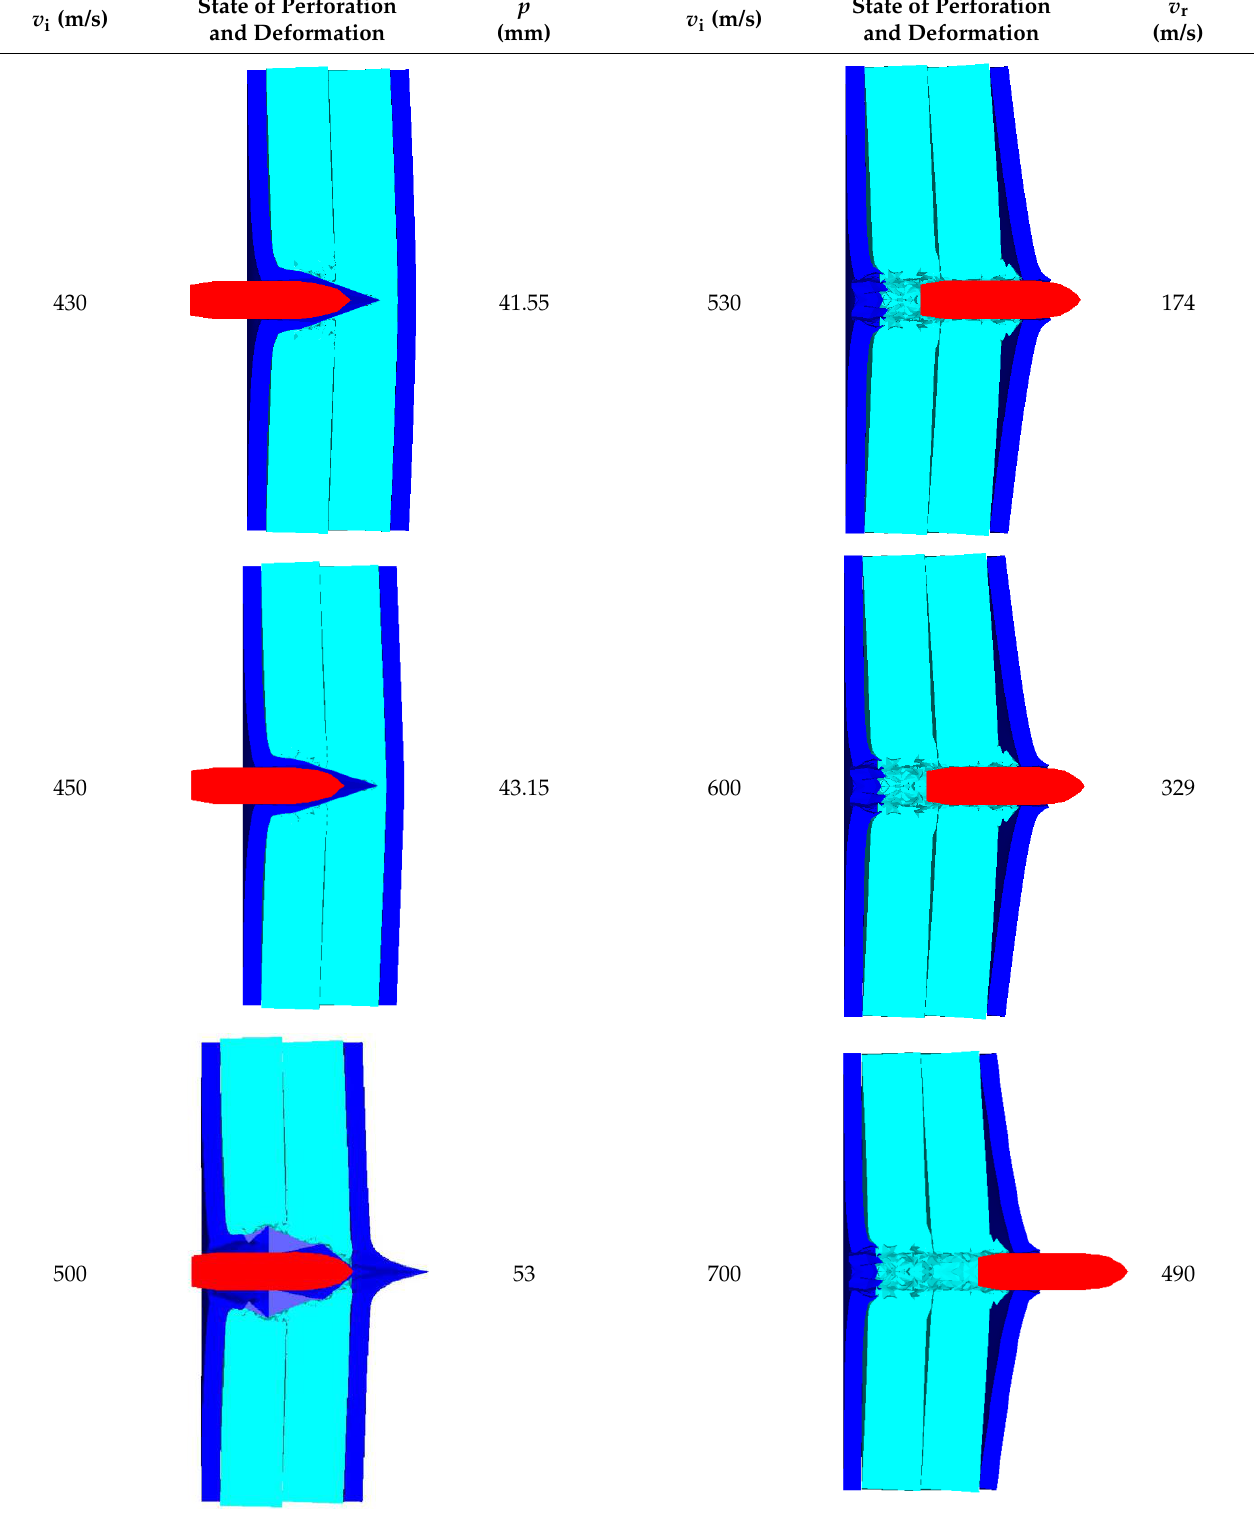
Table 8. Numerical simulation results of perforation.